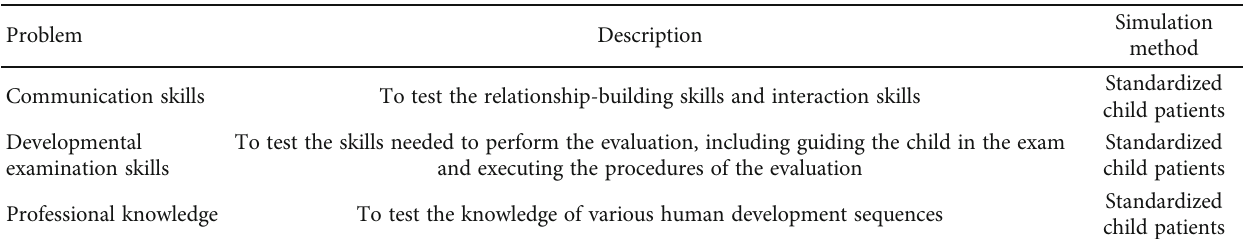
Figure 1: Timeline of the study for the students in the experimental and control groups. Table 1: Content of the situated simulation-based